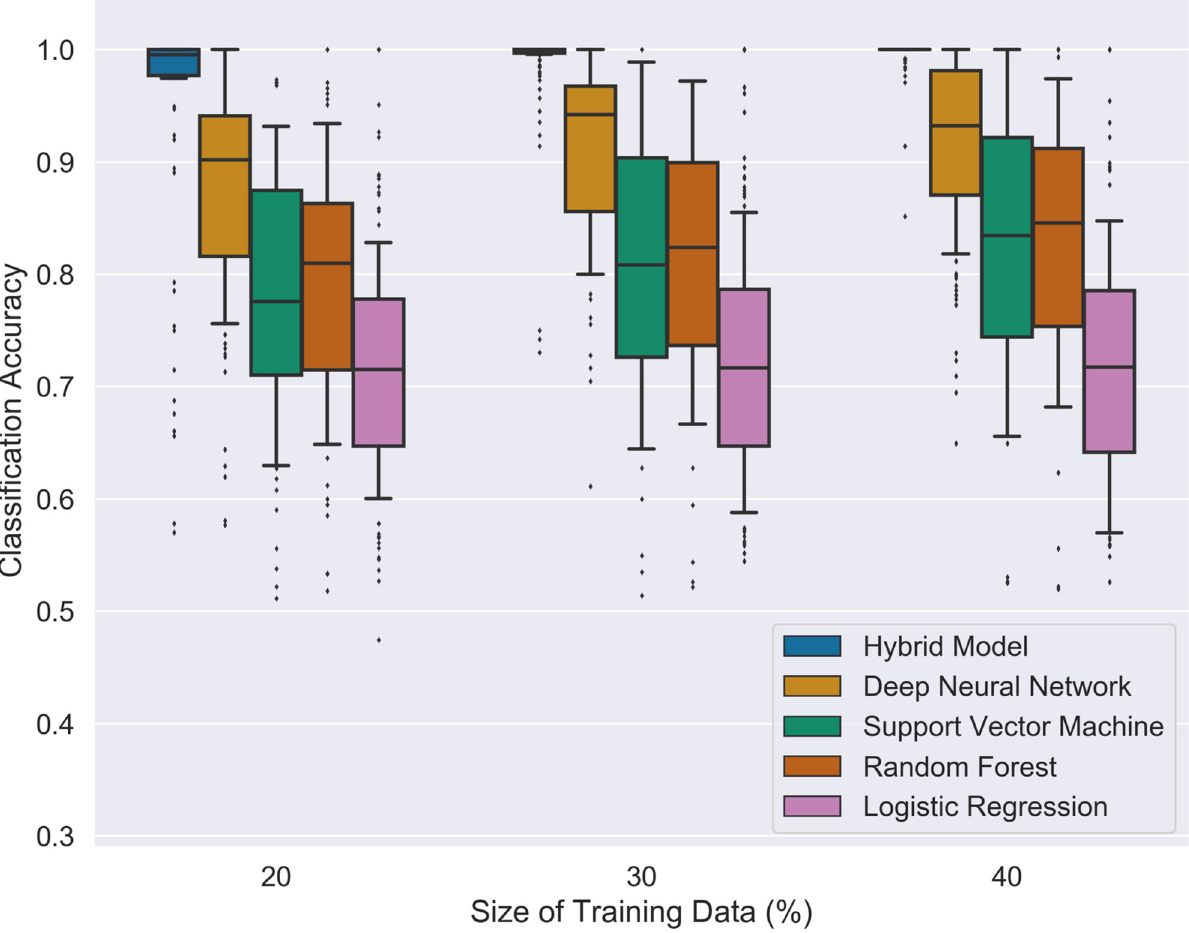
Fig 5. The distribution of classification accuracies for binary classification on the synthetic data. For each model and each size N tr of the training data, we sampled 150 training data sets with input dimension d 2 {8, 9, 10, 11, 12} and visualized the measured performance as box plots.